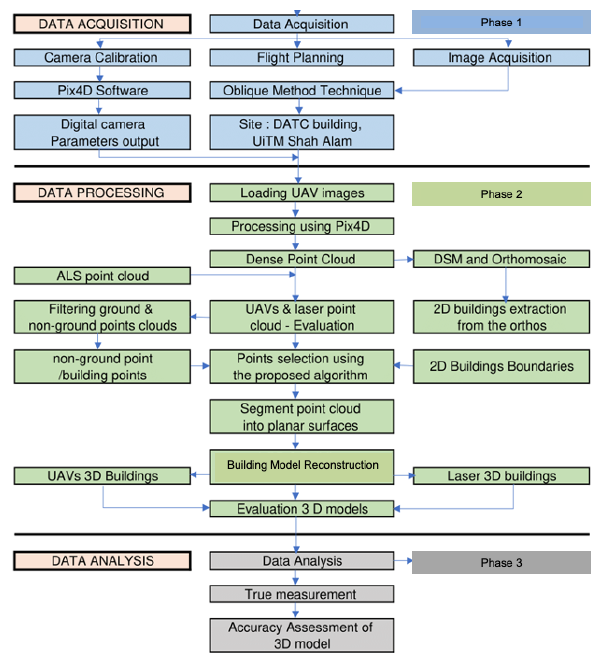
Figure 2. The detail of